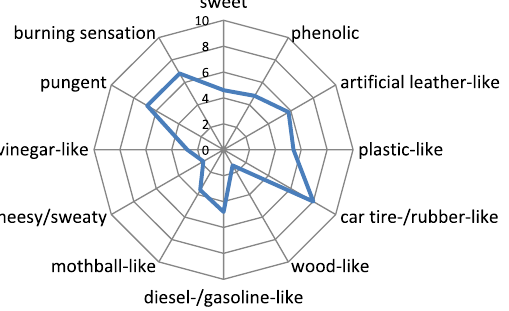
Figure 1. Odour profile of the investigated sample. The data are displayed as mean numerical values of the sensory evaluation of five